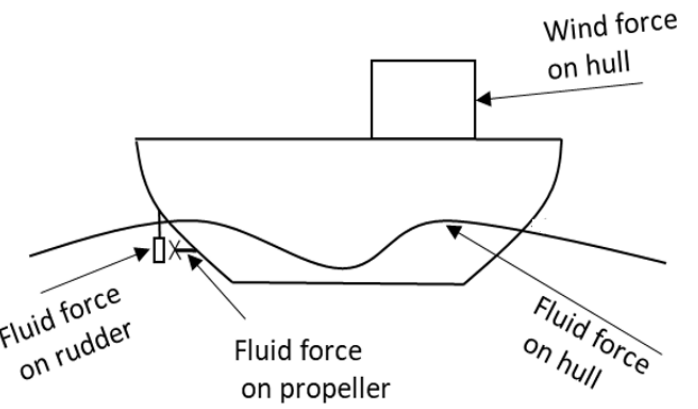
Figure 10. Force diagram of the USV during